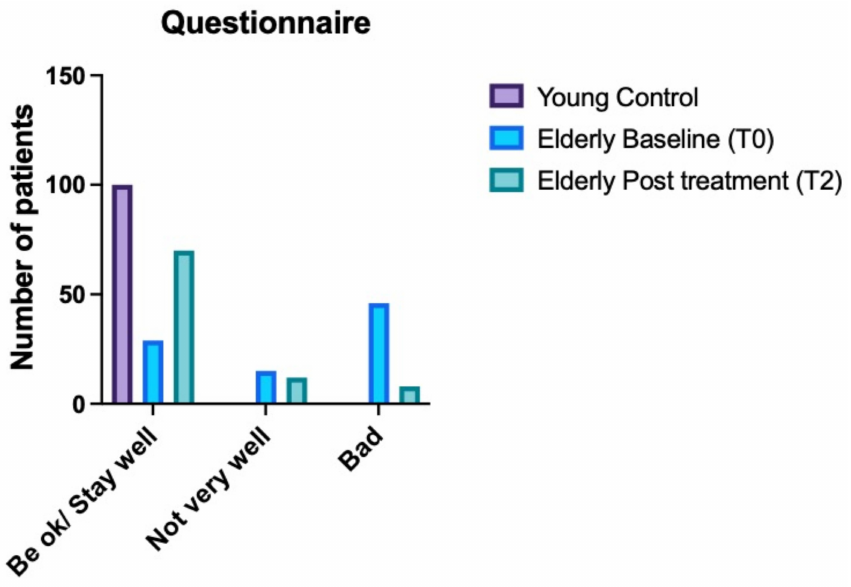
Figure 5. The bar graph shows the patients’ answer to the administered self-questionnaire for evaluating their health condition before and after